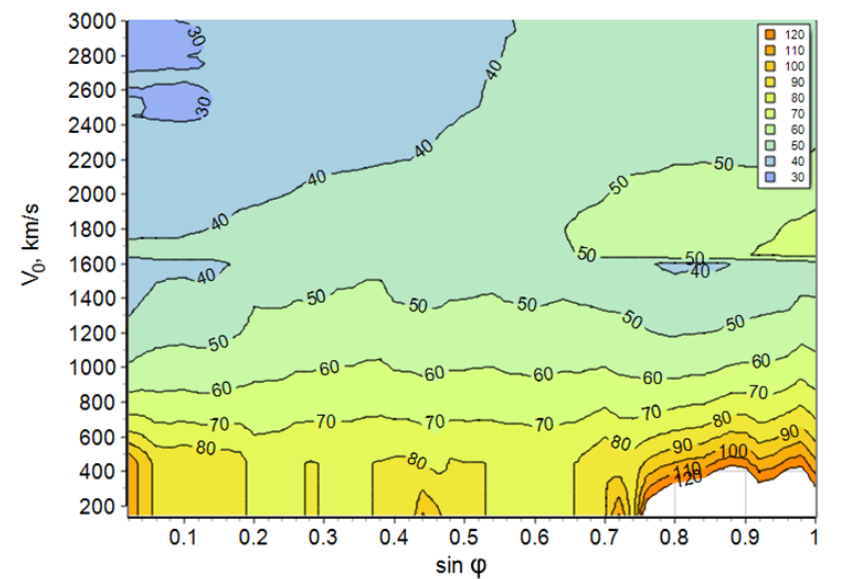
Figure 6. The relation of the expected ICME transit time to the initial CME speed and the sine of the associated flare absolute heliolongitude. Different colors indicate the gradation of the expected propagation time in